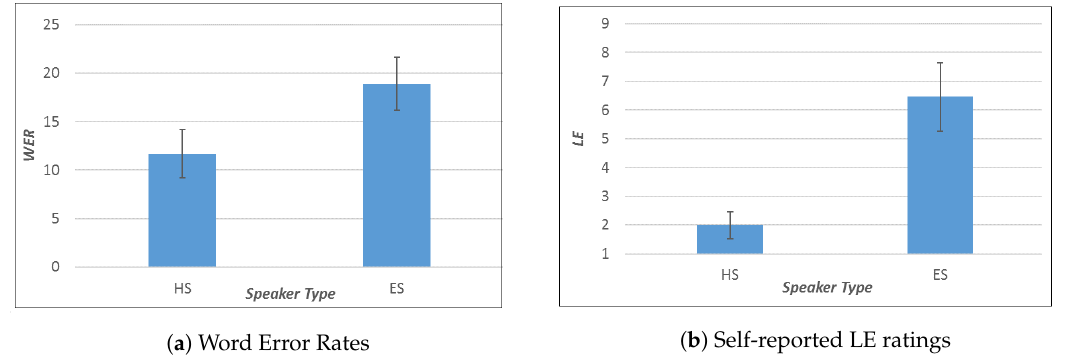
Figure 4. WERandLEforoesophageal(OF1)andhealthy(HF1)speakers.